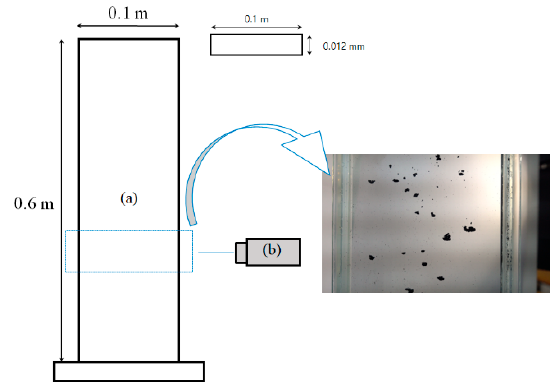
Figure 2. Experimental apparatus: ( a ) Sedimentation column; ( b ) camera .